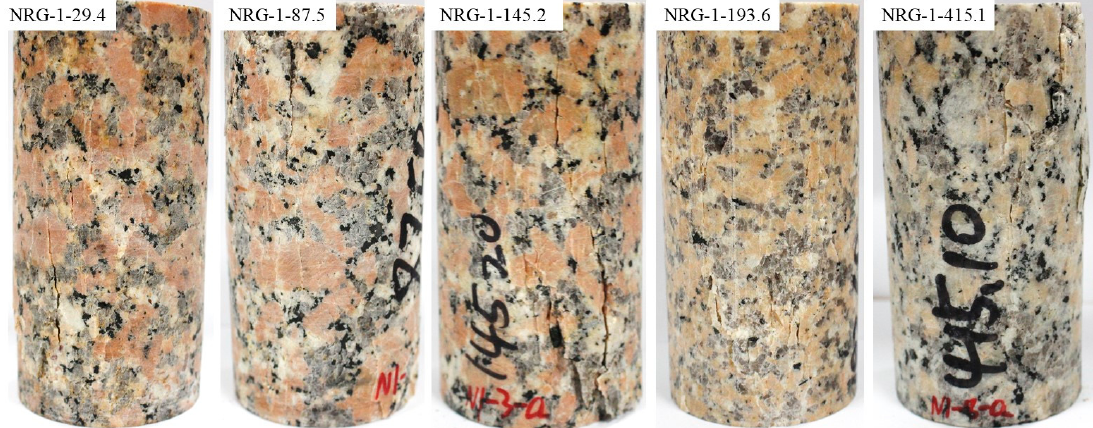
Figure 3. The failure characteristics of Alxa porphyritic granites after the uniaxial compressive tests.